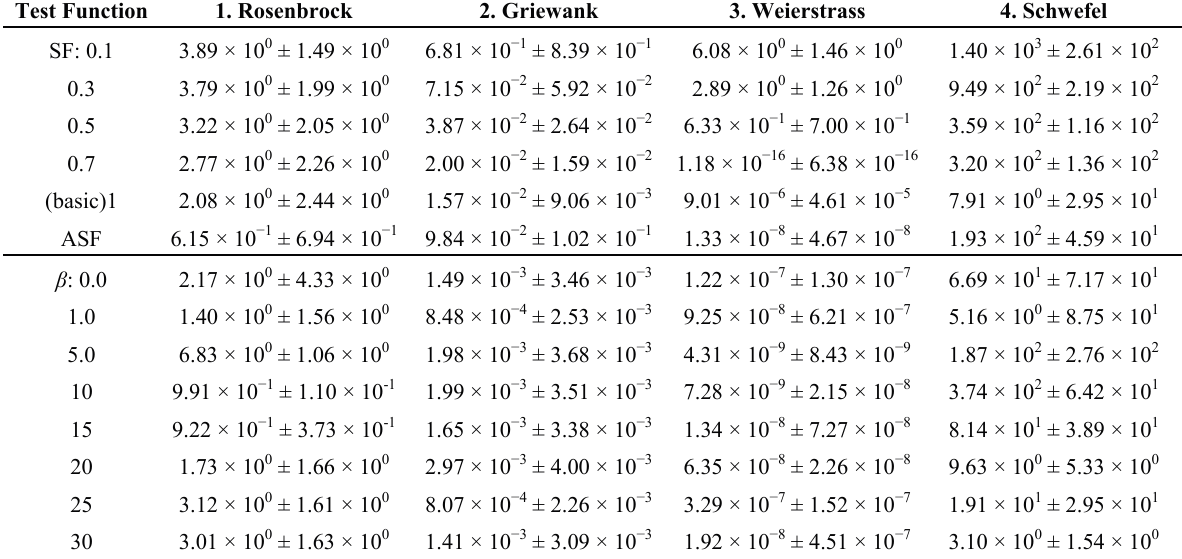
Table 4. Best results of basic test functions. (Dimension: 2, Colony Size: 10, Run times: 30, Maxcycles: 30,000).